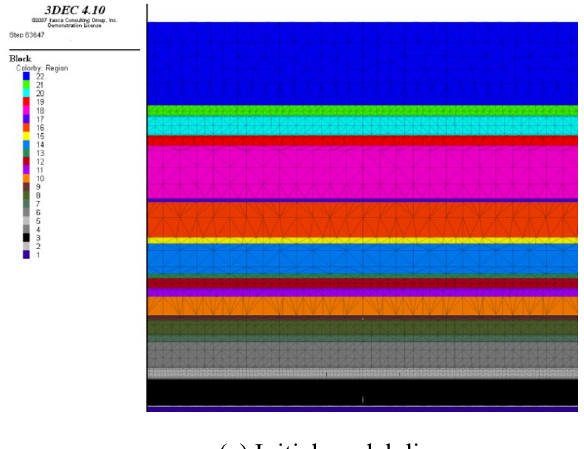
Fig. 6 Discontinuous surface cracking of the 12,401 ground subsid- ence